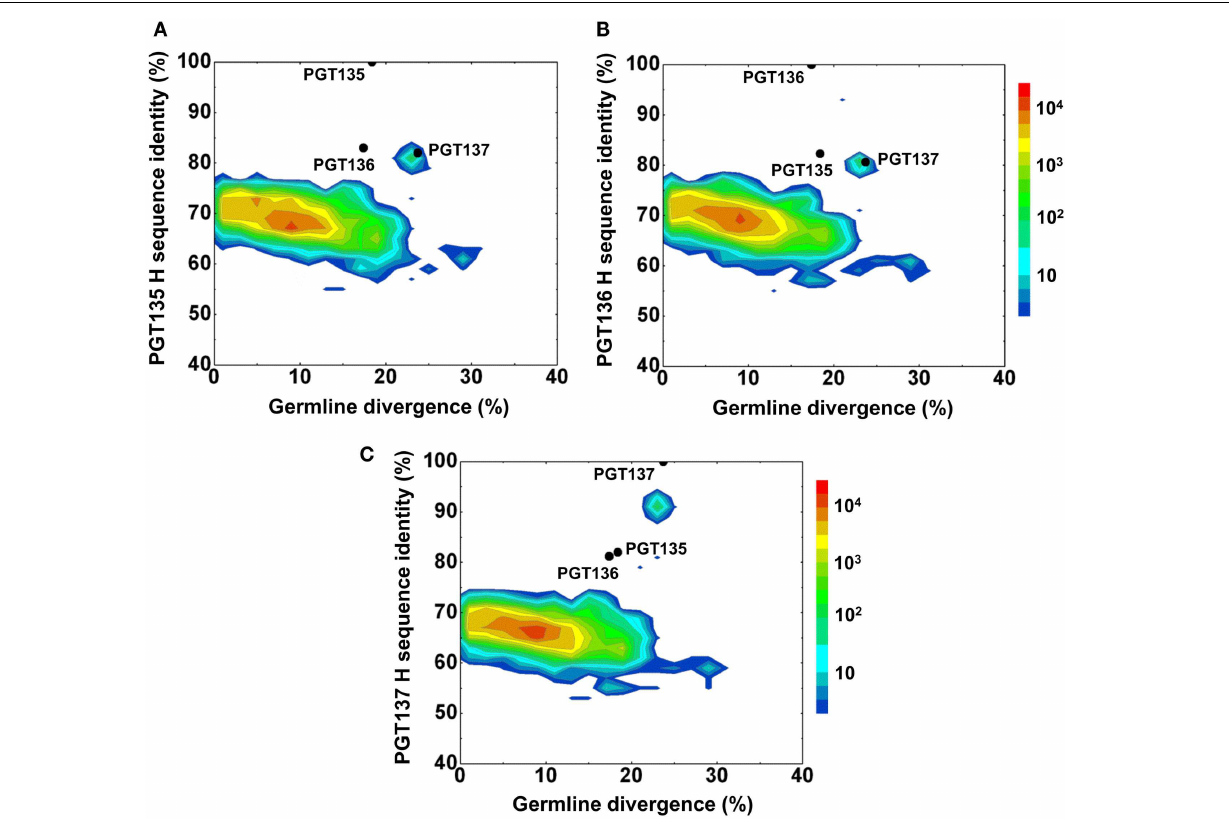
FIGURE 2 | Repertoire of donor 39 heavy-chain variable-domain sequences of IGHV4-39 origin determined by 454 pyrosequencing. After processing by a standard bioinformatics pipeline (see Materials and Methods), 1,41,298 full-length, heavy-chain variable-domain sequences from IGHV4-39 germline family were obtained.These are plotted as a function of